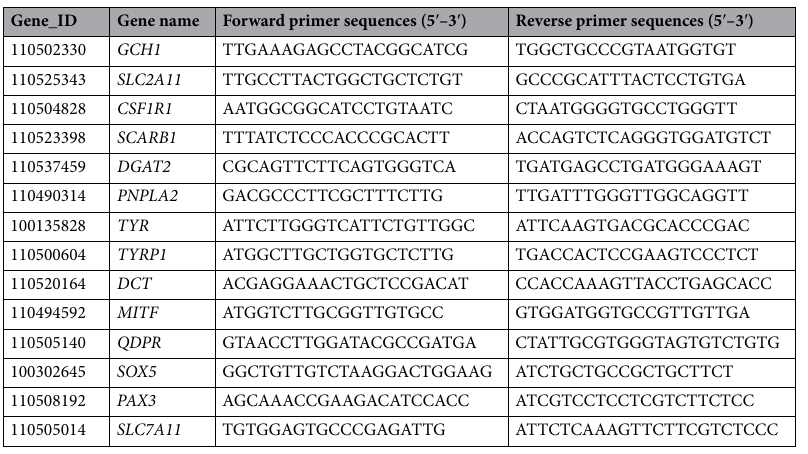
Table 2. Primers used for qRT-PCR of selected genes.